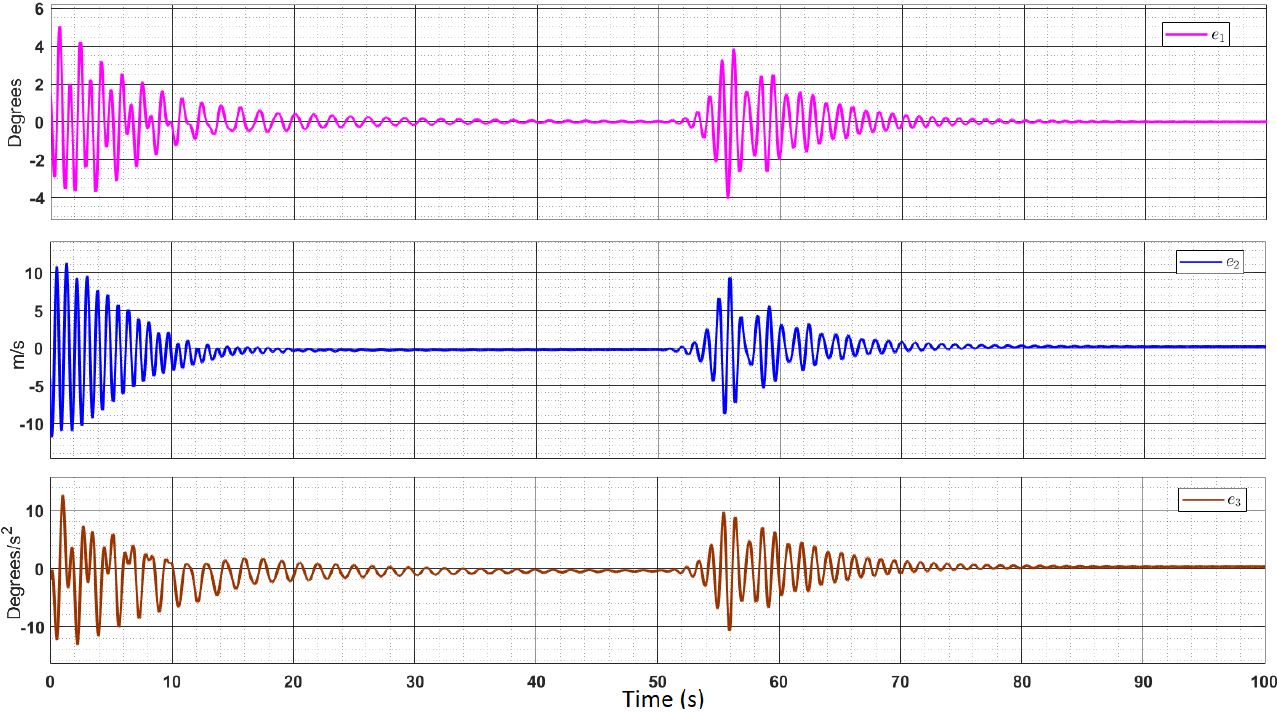
Figure 19. State errors.